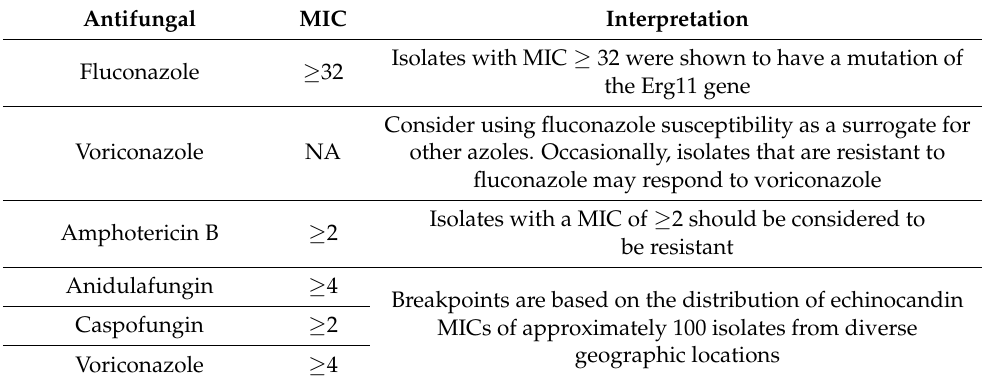
Table 1. C. auris -specific antifungal susceptibility interpretation according to CDC [21].